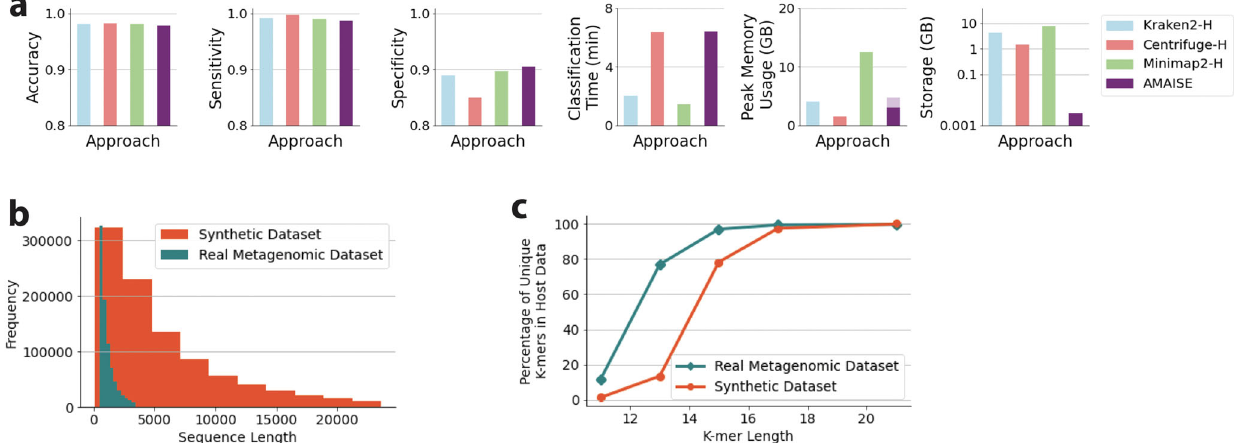
Fig. 3 Performance of all methods on a real metagenomic test set; and comparison of the real metagenomic test set and synthetic test set. a On real metagenomic data, AMAISE achieved a slightly higher speci fi city than other methods and remained competitive with respect to accuracy, sensitivity, classi fi cation time, and peak memory usage. b Length of real metagenomic test set vs. the synthetic test set. The real metagenomic data, on average, contained shorter sequences than the synthetic data. c Percentage of unique host k -mers in the real metagenomic test set compared to the synthetic test set. The real metagenomic data contains more unique 11-mers, 13-mers, 15-mers, and 17-mers in the host fraction compared to the synthetic data, which suggests that classifying the real metagenomic data is an easier task than classifying the synthetic